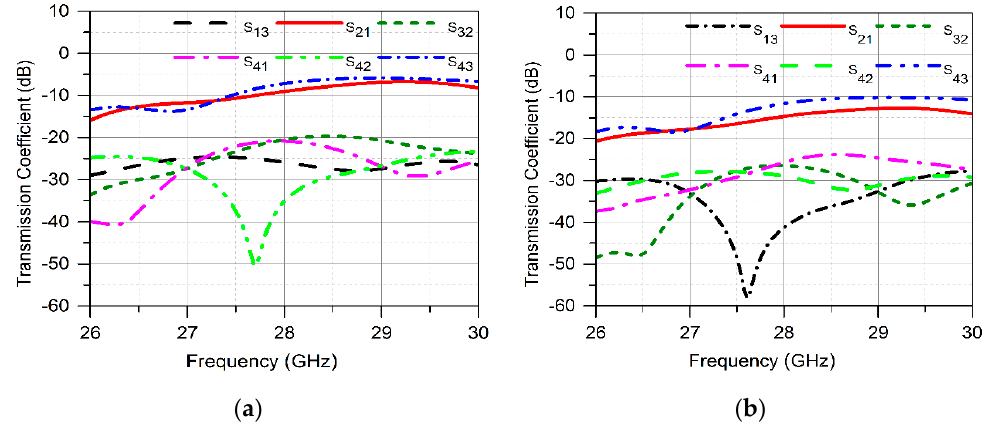
Figure 4. Simulated Transmission Coefficient ( a ) Without DGS ( b ) With DGS.